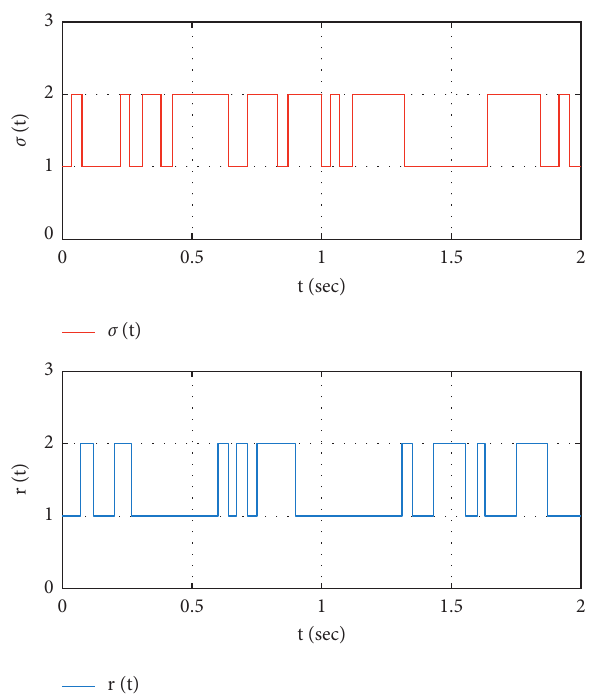
Figure 5: The evolution of the system and controller